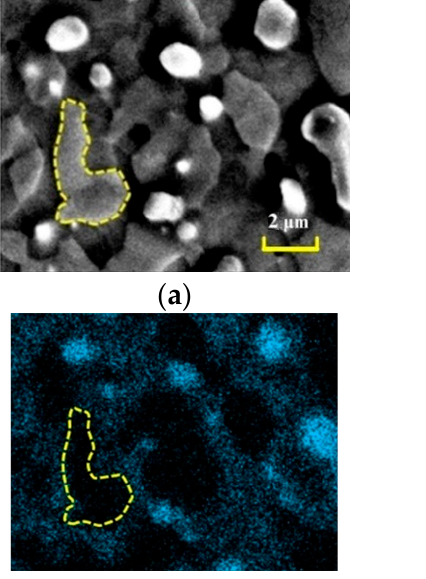
Figure 3. Element distribution map of substrate region. ( a ) SEM micrograph; ( b ) Mo; ( c ) Si; ( d ) B.